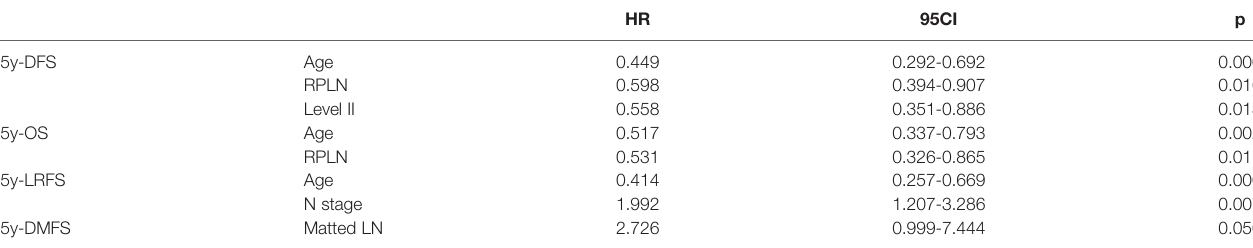
TABLE 4 | Results of multi-variates analysis in identifying factors associated with LRFS, DMFS, OS and DFS.